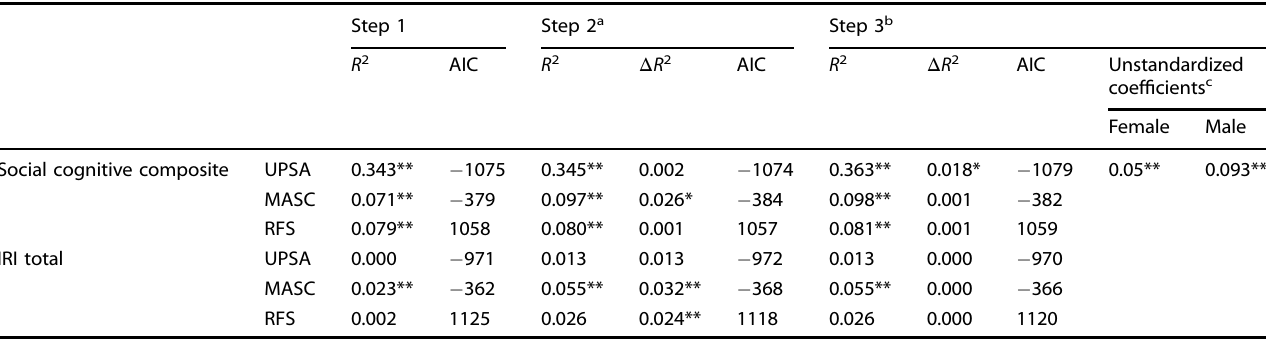
Table 4. Linear multiple regression analyses to examine the moderating role of sex in associations between social cognition and functioning. Step